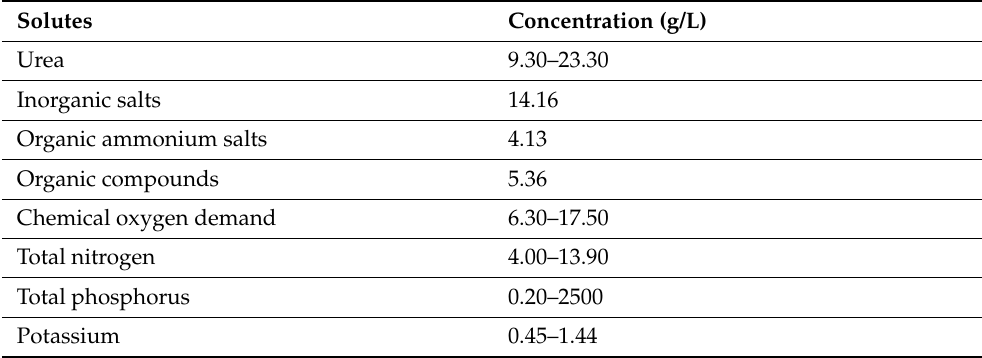
Table A3. Principal solutes in human